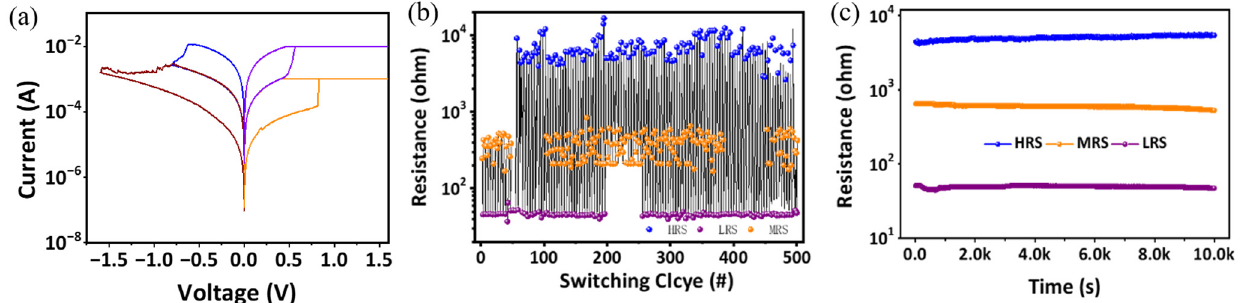
Figure 2. Electrical parameters of the memristor. ( a ) Multistate I-V characteristic curve of memristor; ( b ) The device endurance and ( c ) retention at room temperature.